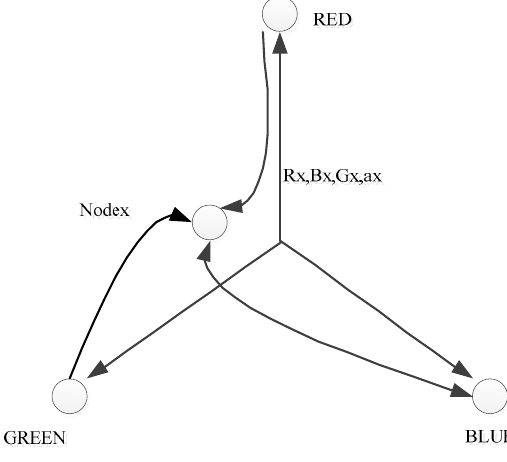
Figure 9. An algorithm of the three-axis method (adapted from [17]).